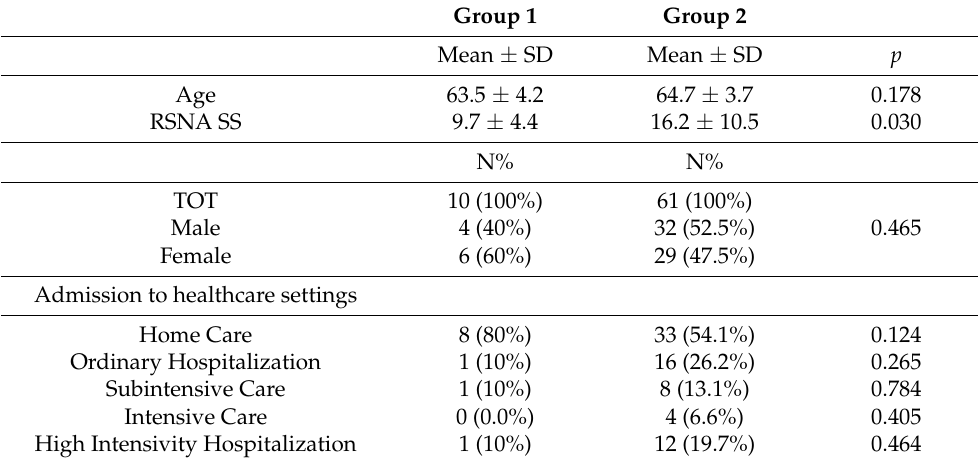
Table 1. It shows the main characteristics of the study sample, represented by mean with standard deviation, absolute number, frequency with the respective p -value. Group 1: Ad26.COV2-S vacci- nated; Group 2: non-vaccinated; RSNA SS: RSNA severity score; HC: Home Care; OH: Ordinary Hospitalization; SC: Subintensive Care; IC: Intensive Care; HI: High Intensivity Care (SC+IC); SD: Standard Deviation.